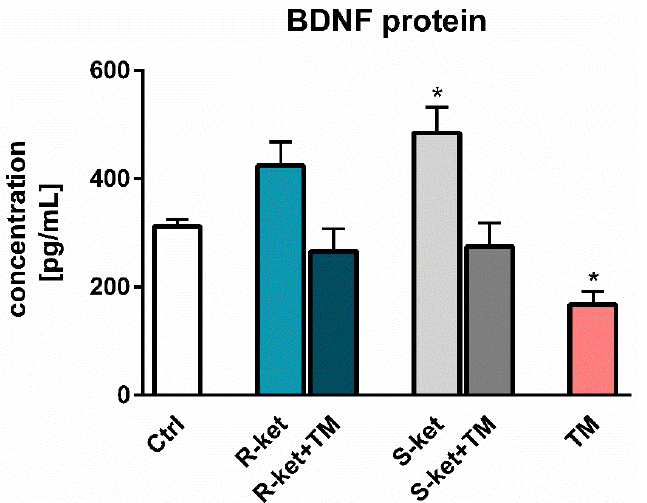
Figure 7. Effects of tunicamycin alone (TM), R-ketamine alone (R-ket), S-ketamine alone (S-ket) or R-ketamine and S-ketamine in tunicamycin-treated astrocytes (R-ket + TM or S-ket + TM) on BDNF protein release. Data are presented as the mean ± SEM and expressed as a percentage of untreated control cells. Statistical significance vs. control cells is indicated when appropriate; * p <